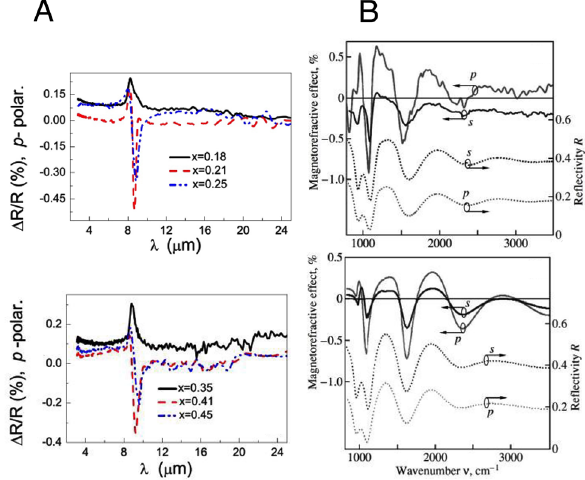
Figure 8: MRE spectra for different types of TMR